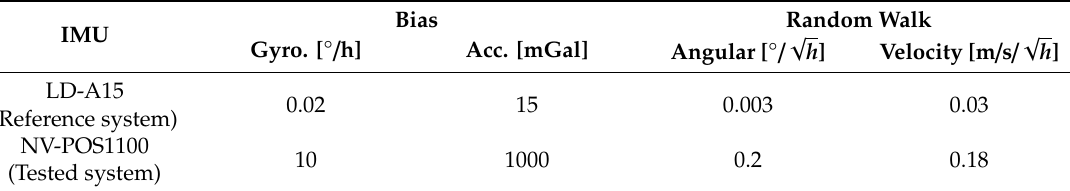
Table 1. Technical Parameters of LD-A15 and NV-POS1100.